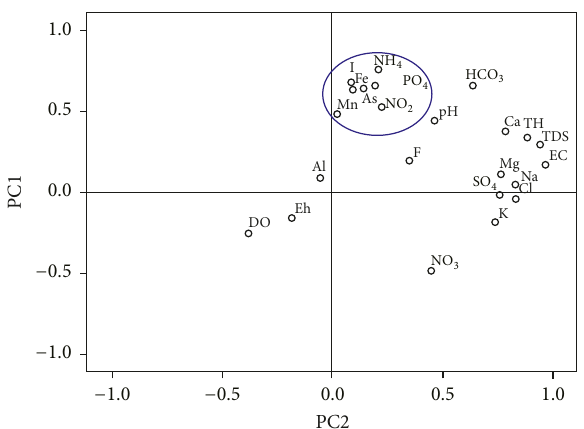
Figure 4: The relationship of hydrochemical parameters in two main PCs in granular